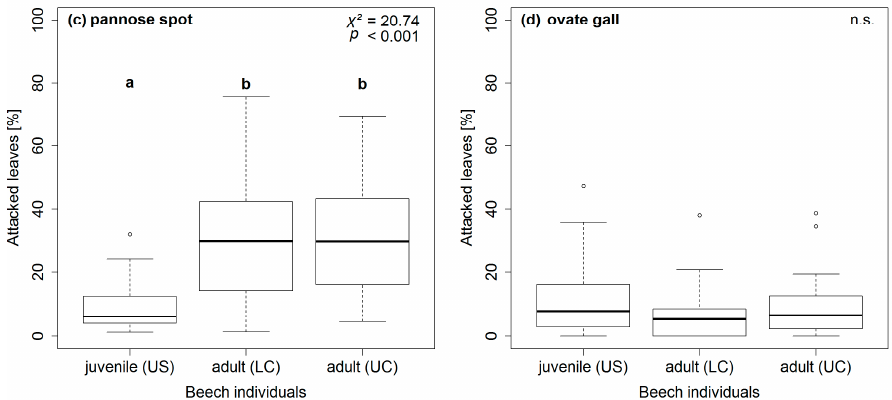
Figure 3. Distributions of herbivore attack levels for identified feeding traces along the vertical forest